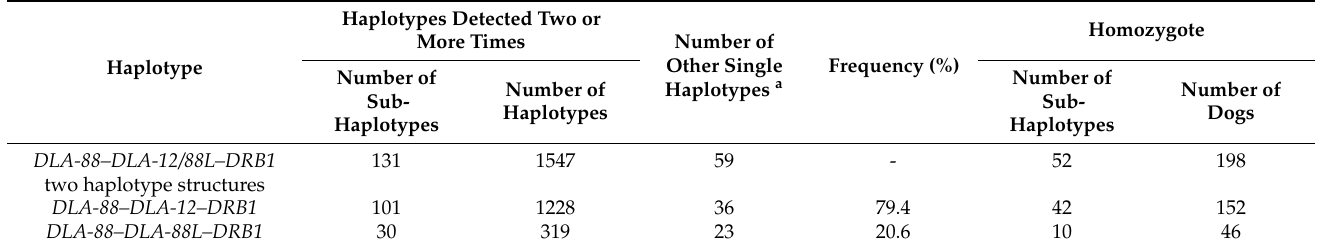
Table 3. Summary of the three-locus haplotypes assigned to 803 dogs of 49 breeds and